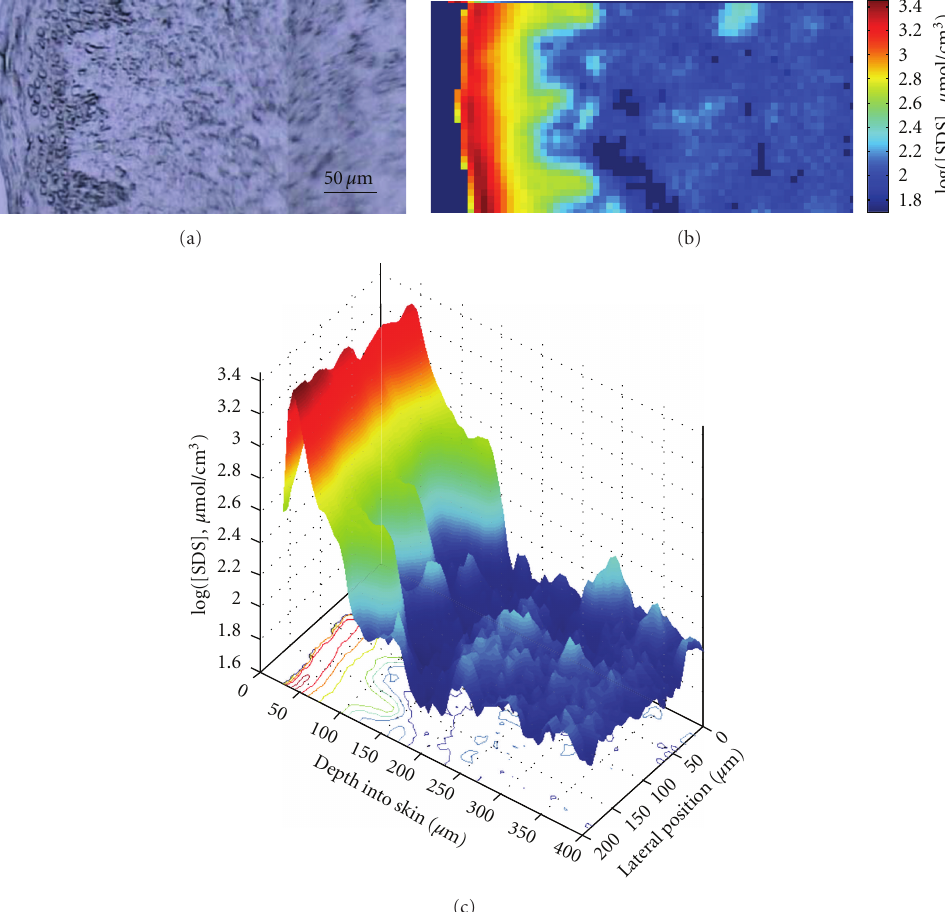
Figure 3: (a) Visible light microscopic image of human skin cross-section, distribution of SDS concentration in the same skin section following 40h topical SDS treatment at 34 ◦ C, (b) shown as an IR image map, and (c) shown as a 2D depth